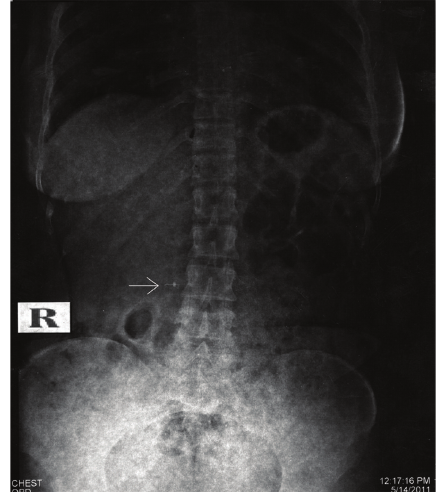
Figure 2: Abdomen radiograph after half an hour, showing instrument in lumbosaccaral region of intestine.